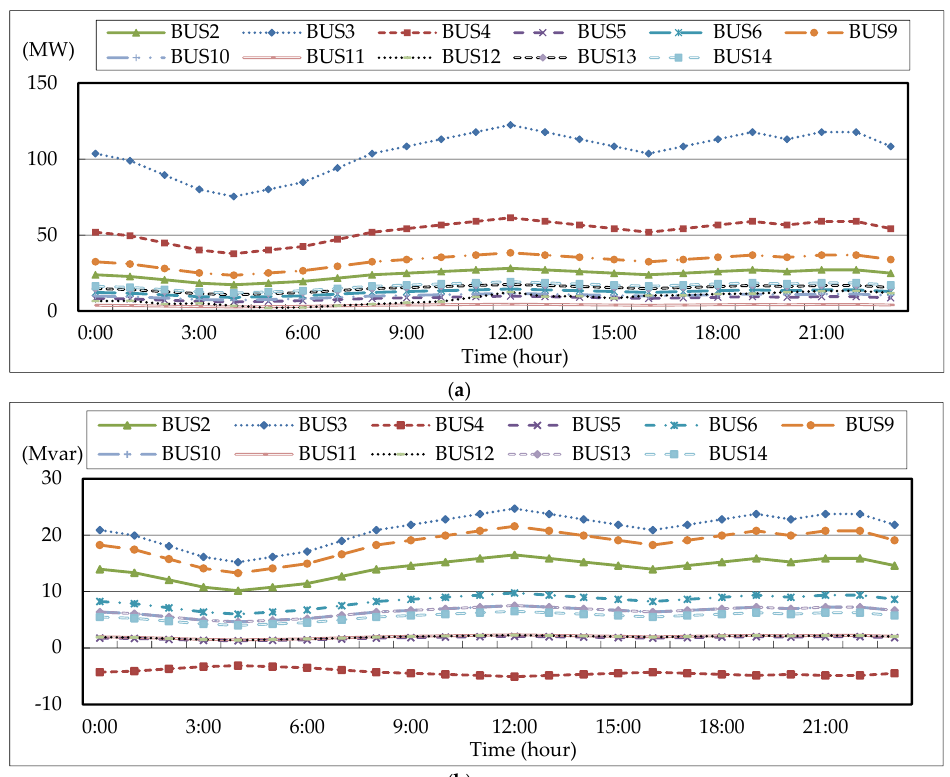
Figure 6. Daily load curve of the IEEE 14-bus test system, ( a ) real power; ( b ) reactive power.